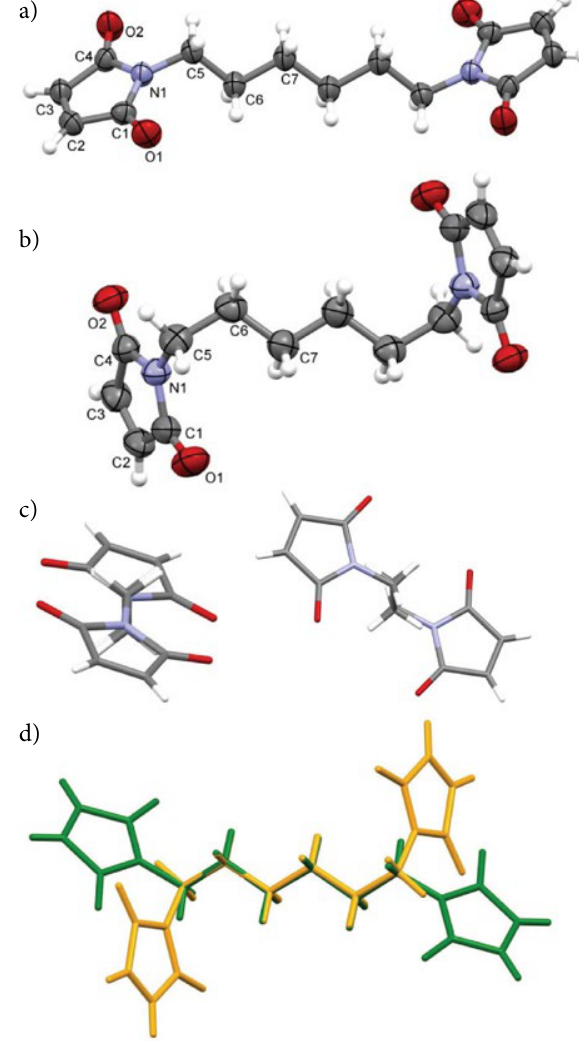
Figure 1. Molecular structure and atom numbering scheme for a) 2a and b) 2b . Probability ellipsoids are drawn at the 50% level. c) View along C chain for 2a (left) and 2b (right). d) Molecular over- 6 lay of polymorphs 2a (green) and 2b